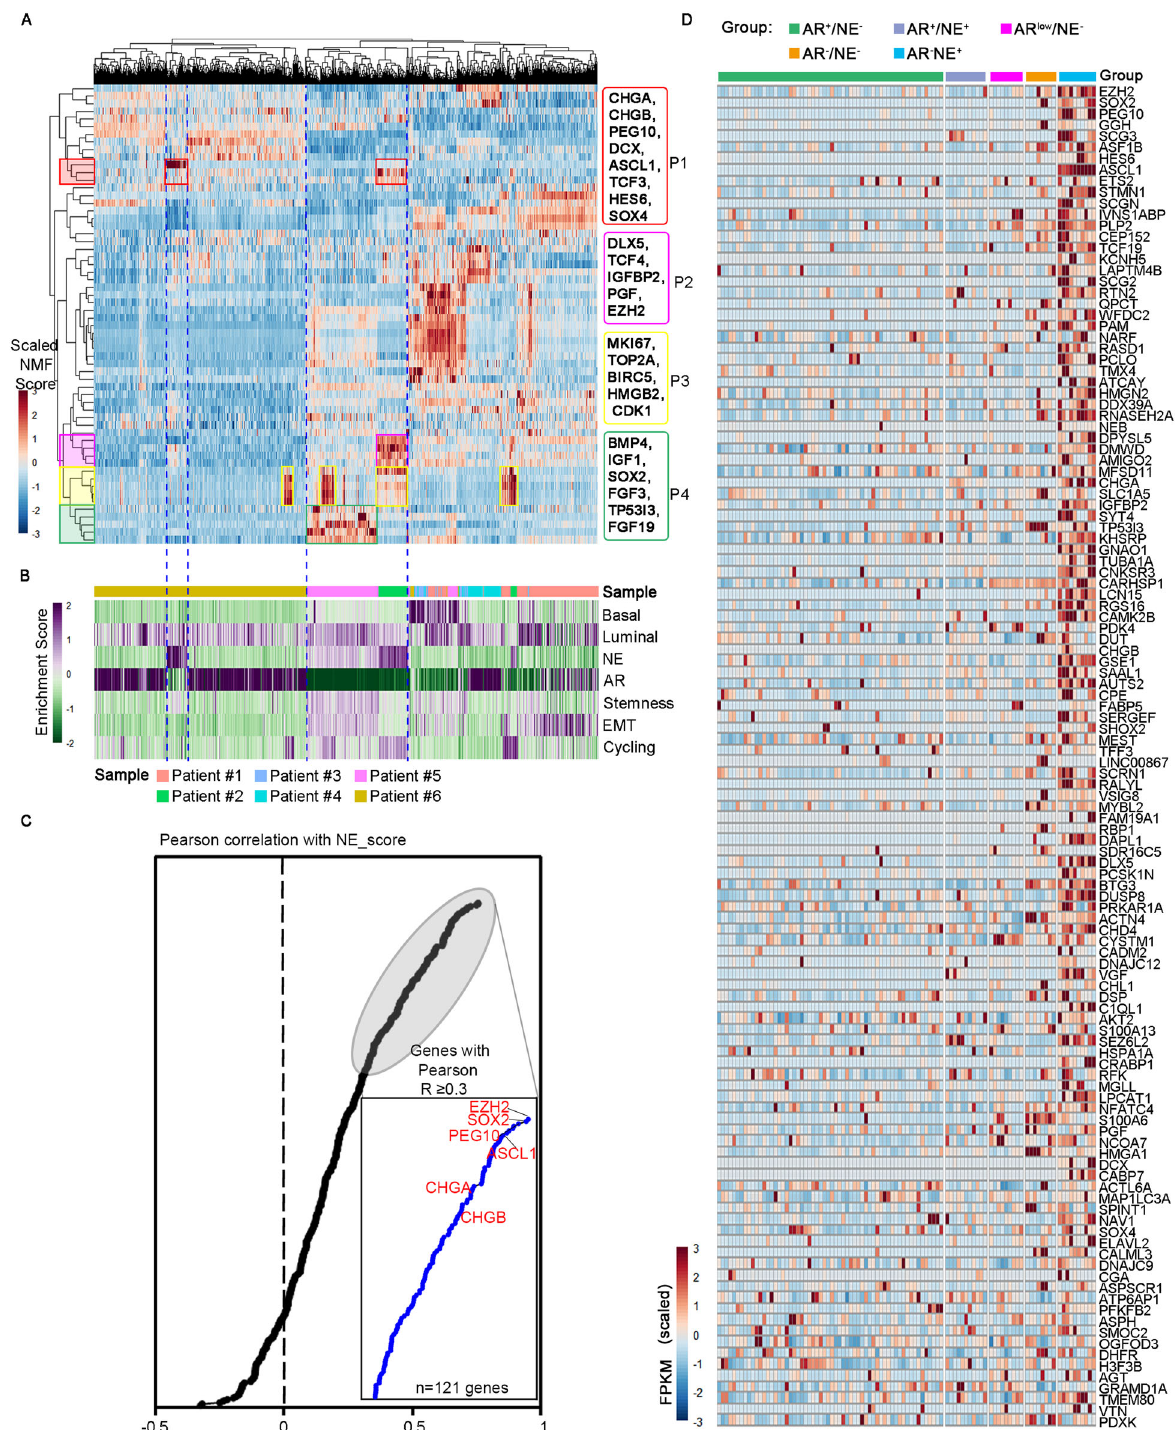
Fig. 6 Intra-tumoral meta-programs underlying NED. A Heatmap showing scores of 12861 epithelial cells (column, from 6 CRPC patients) for each of 60 programs (rows) derived from NMF analysis of individual samples. Cells and programs are hierarchically clustered, and 3 NE-related meta-programs (P1, P2, and P4) and a cell cycle-related meta-program (P3) are highlighted. B Enrichment scores of prostate lineages: basal, luminal, NE marker genes and AR, stemness, EMT, and cell cycle pathway genes in cells ordered as in ( A ), with the color-coding for the corresponding CRPC sample. C Pearson correlation between the expression of genes of P1, P2, and P4 and the NE score, as measured by the average expression of 14 known NE markers. Three previously published bulk RNA-seq datasets were used in this analysis, as described in the “ Methods ” section. Highlighted in red are some known NED genes (Source data are provided as Supplementary Data 1). D Heatmap depicting strong expression of 121 genes (Pearson R ≥ 0.3, as measured by Pearson correlation analysis shown in ( C ) in AR − NE + group of Morrissey dataset. Total samples are divided into fi ve groups as previously suggested in ref. 40